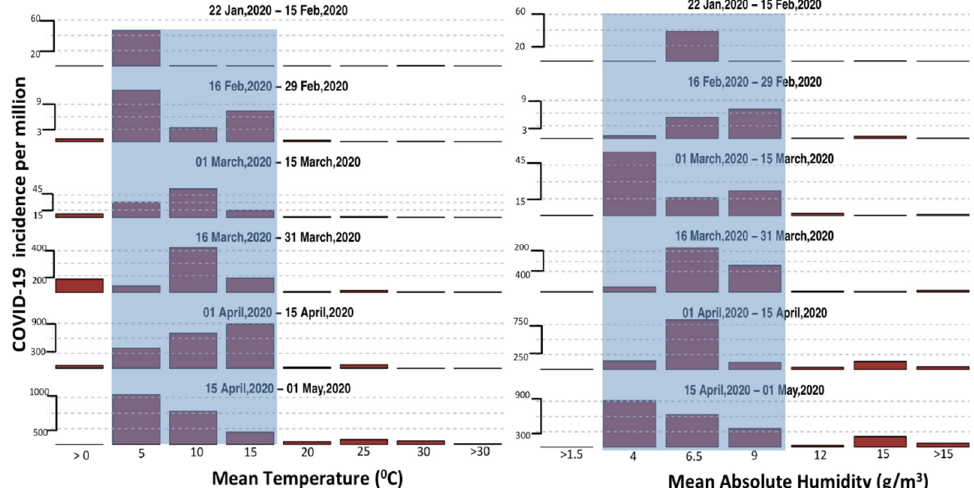
Figure 4. Number of COVID-19 cases across the world as a function of temperature and absolute- humidity. The figure shows the number of cases reported COVID-19 cases per 10-day period for different temperature and absolute humidity values. Temperature and absolute humidity range with the majority of COVID-19 cases (>85%) is highlighted with light blue color and is consistently between 3 and 17 °C for temperature and between 4 and 9 g/m 3 for absolute humidity every week.